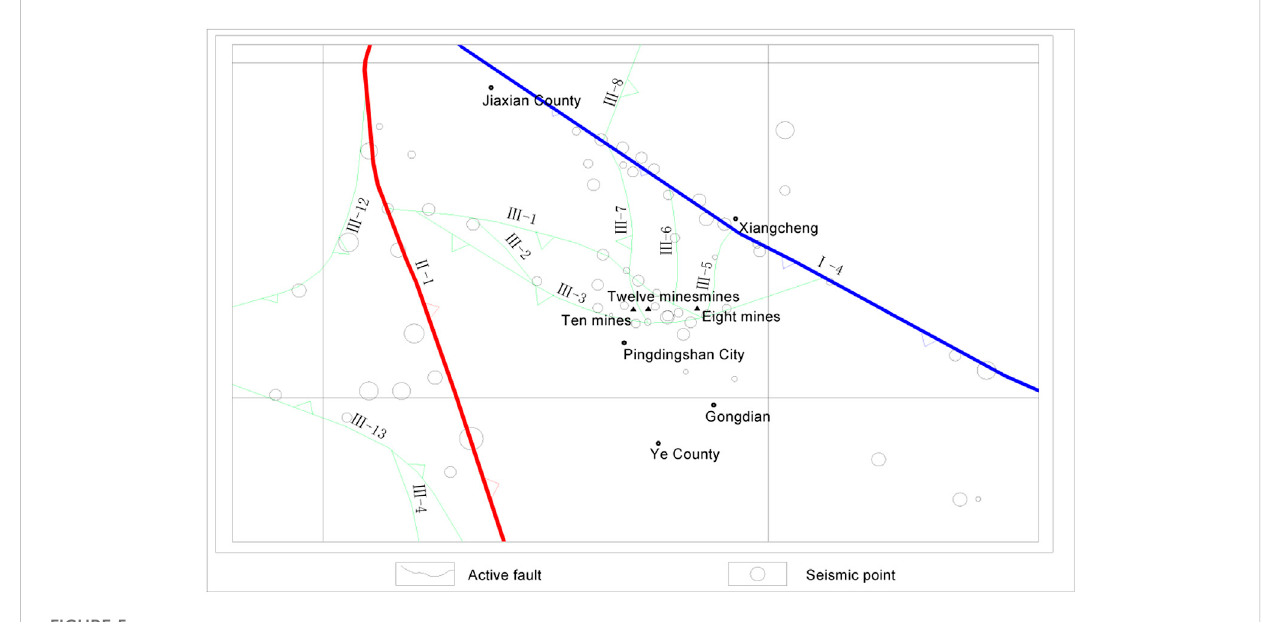
FIGURE 5 Grade III division and seismic distribution in the mining